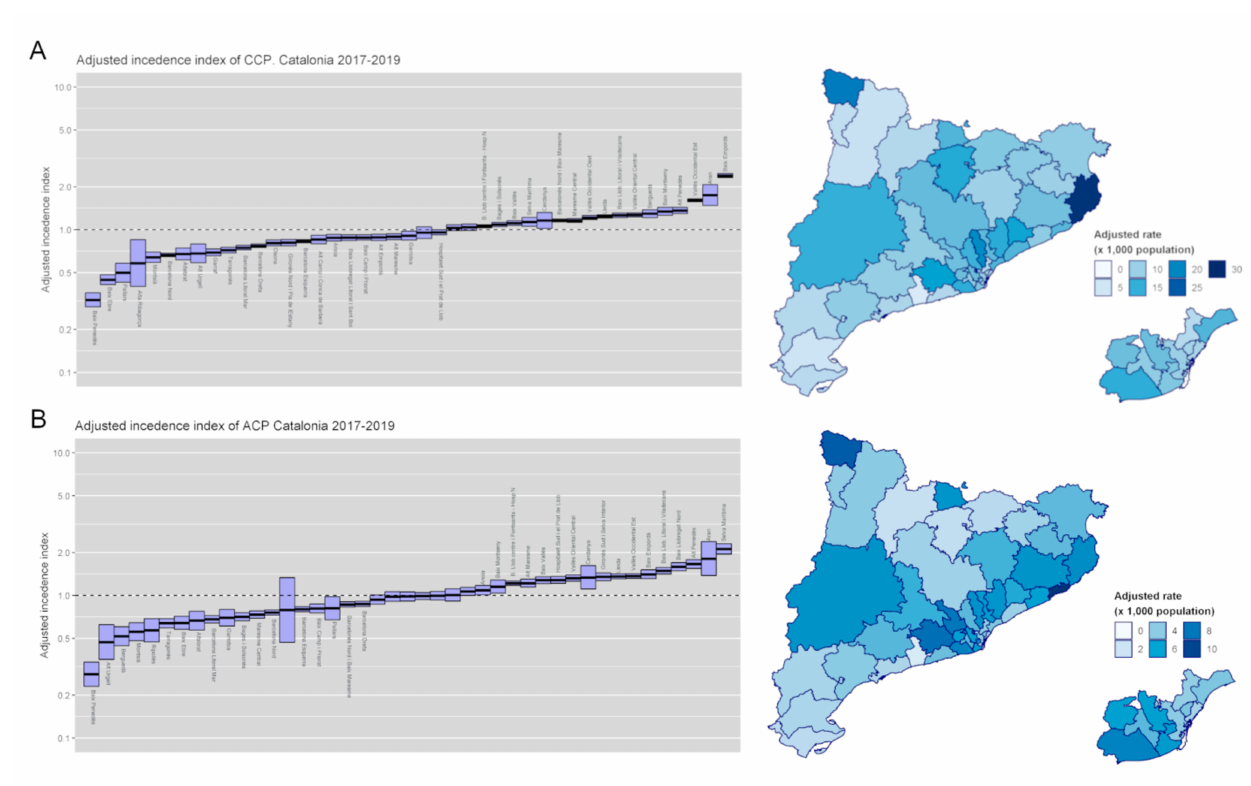
Figure 7. Incidence of ( A ) chronic complex patients (CCPs) and ( B ) advanced chronic patients (ACPs) adjusted by age, sex, comorbidities, and income level in the different regions of Catalonia in